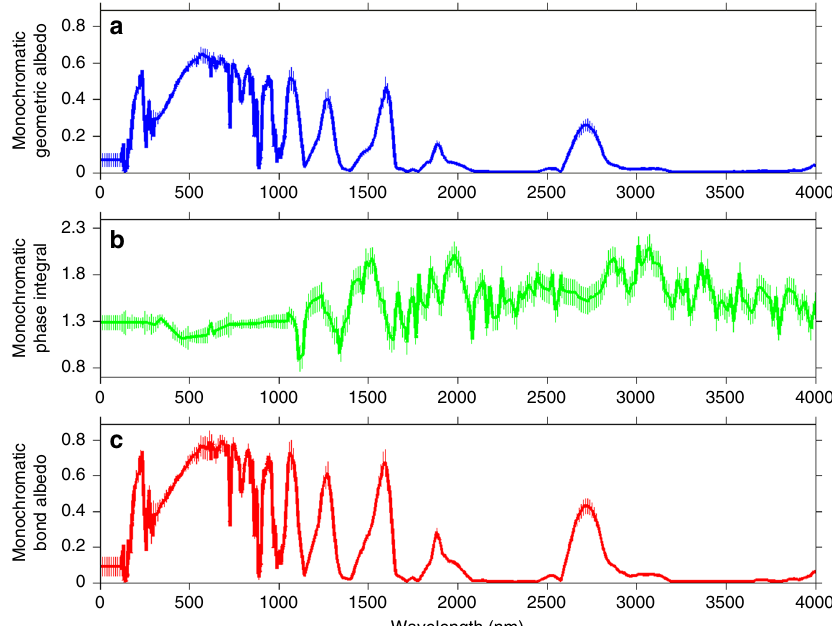
Fig. 3 Jupiter ’ s monochromatic geometric albedo, phase integral, and Bond albedo. a Monochromatic geometric albedo. b Monochromatic phase integral. c Monochromatic Bond albedo. Vertical lines in the three panels represent error bars of